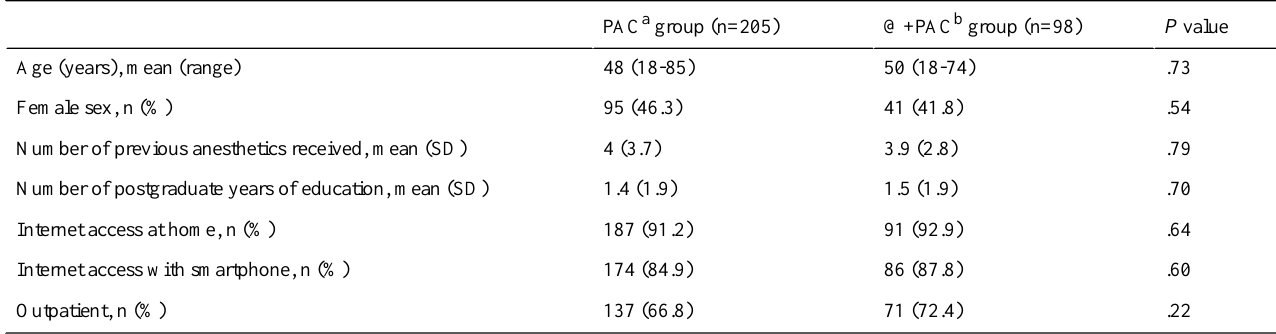
Table 1. Patients’characteristics.